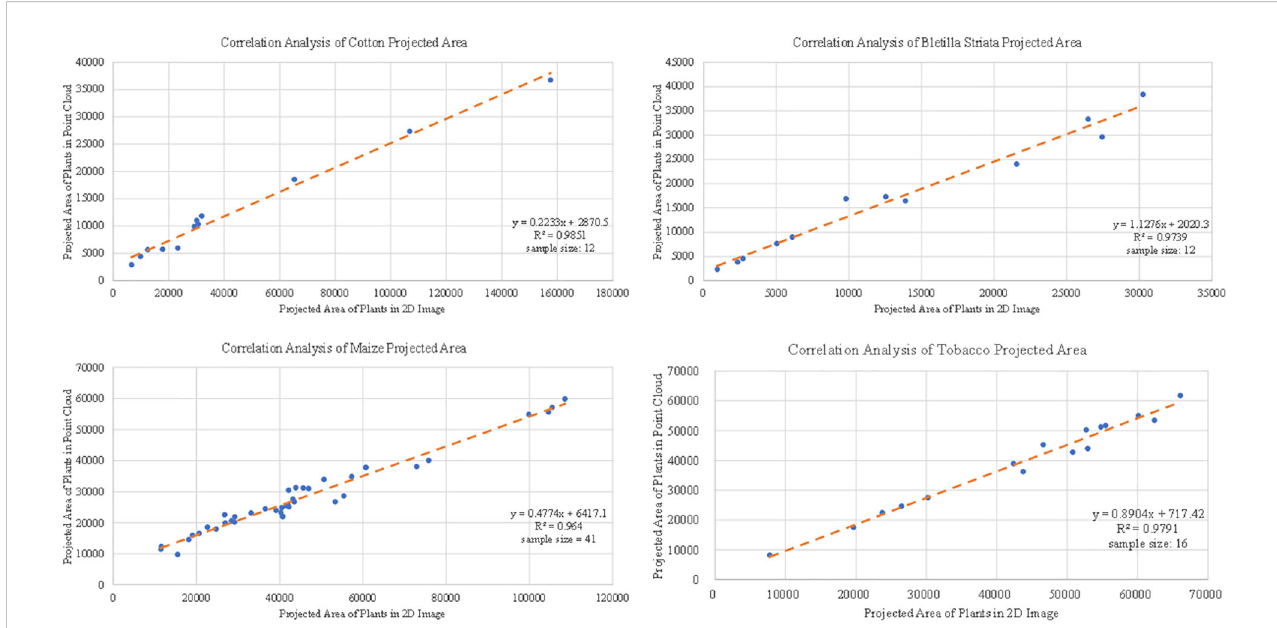
FIGURE 12 Correlation analysis of the projected area data of single crops obtained based on 3D point cloud for cotton, maize, Bletilla striata and